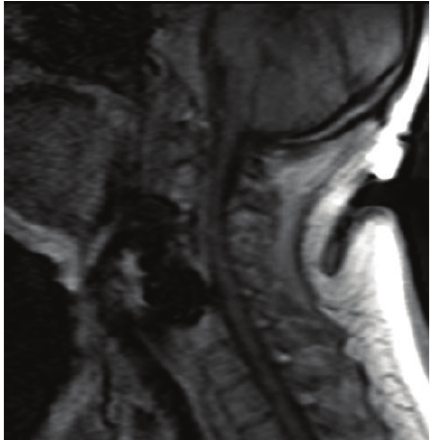
Figure 4: Postoperative MRI in sagittal plane confirming the drainage of the abscess and the subsequent release of the spinal cord pressure.